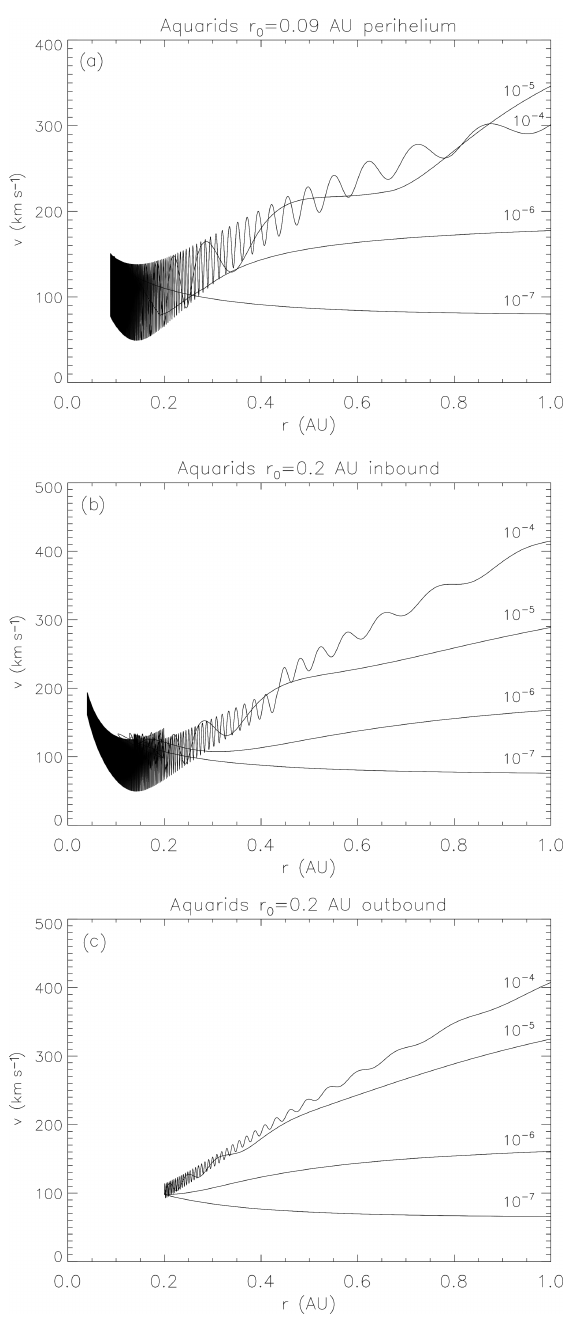
Figure 11. Velocities of small fragments released from Aquarid me- teoroids as a function of the heliocentric distance. The velocities are calculated for dust with Q/m = 10 − 4 , 10 − 5 , 10 − 6 and 10 − 7 e/m p . The ratio of surface charge to mass corresponds to sizes 3nm, 10nm and larger. The particles are released from the orbit of Aquarids at the perihelion (0.09AU from the Sun, a ), and at the distance 0.2AU on the inbound (b) and outbound (c) parts of the orbit. From Czechowski and Mann